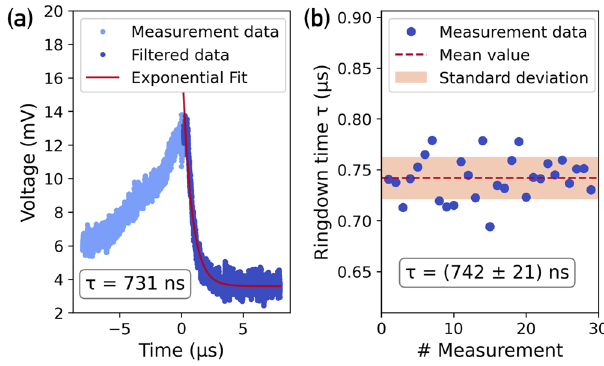
Fig. 6 Measurement results of the cavity ring-down experiment. a One measured ring-down, b All 29 ring-down times, mean value and standard